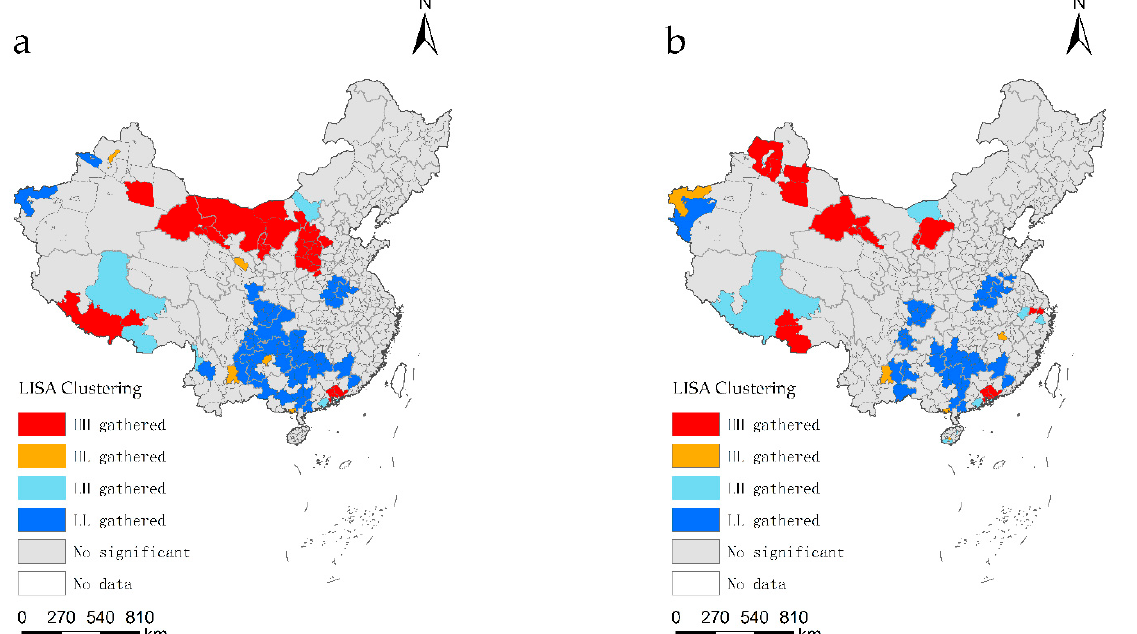
Figure 7. LISA Clustering of per capita internet attention for torrential rain. (Note: ( a ) the internet attention of Shanxi Province; ( b ) the internet attention of Henan Province). (The map is based on the standard map of the Technical Review Centre for Maps of the Ministry of Natural Resources (review number: GS (2019) 1822), with no modifications to the base map).